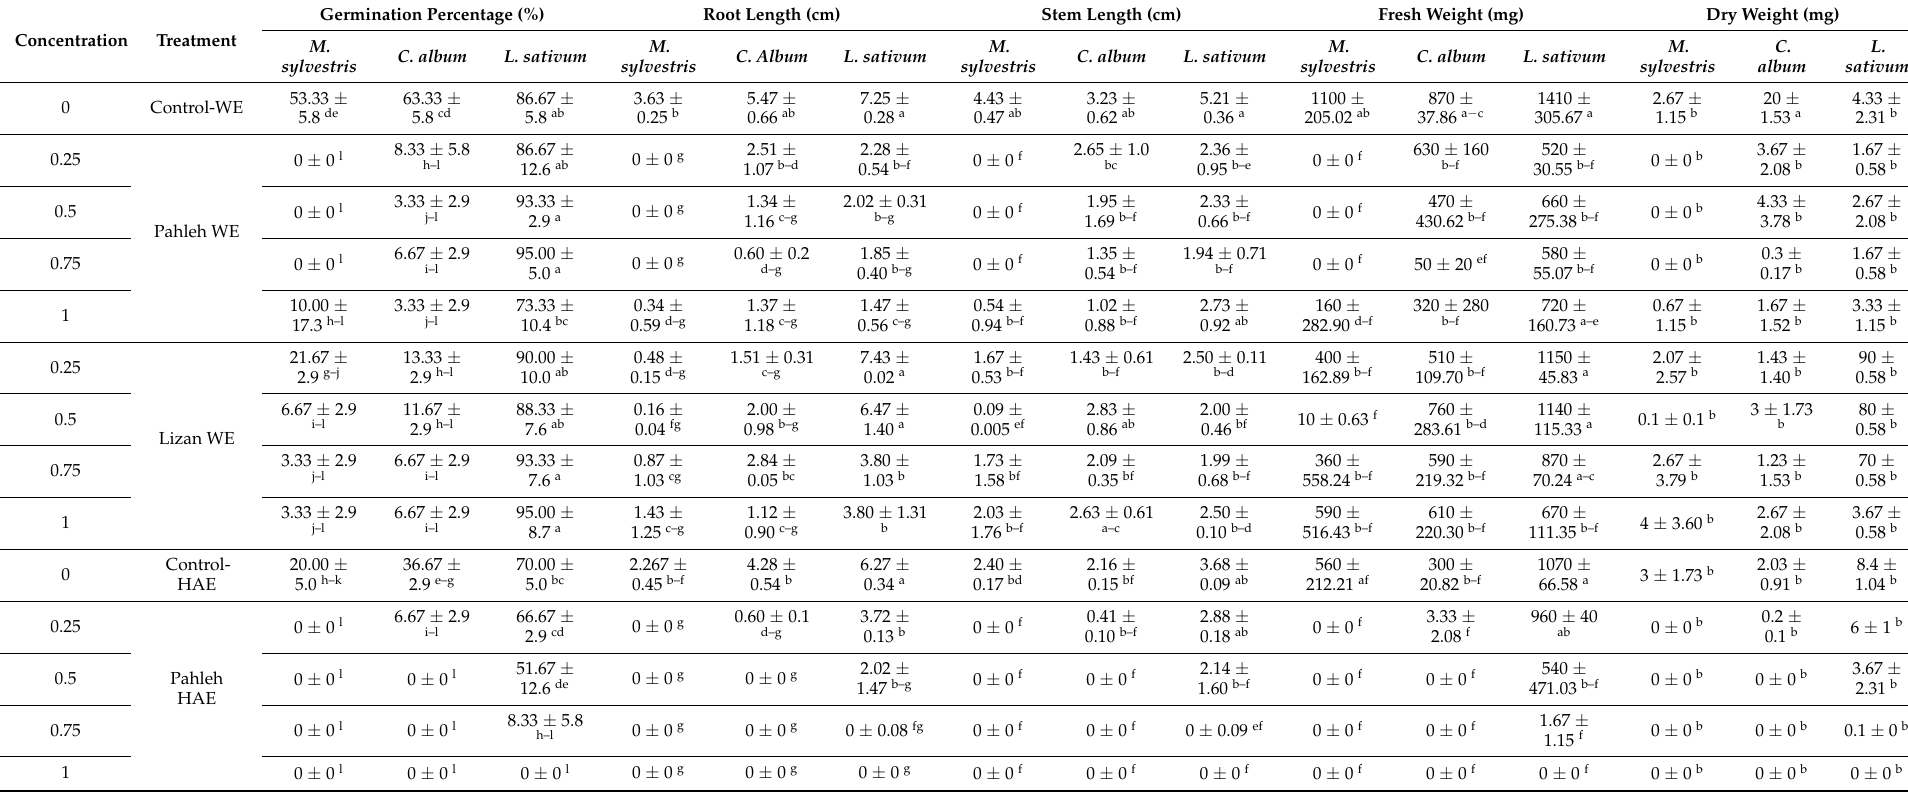
Table 2. Different concentrations of aqueous and hydroalcoholic extracts obtained from Scrophularia striata . The effects of these extracts on germination and several growth parameters of the examined species are shown. Mean values followed by the same letter are not significantly different at p ≤ 0.05 (Tukey’s